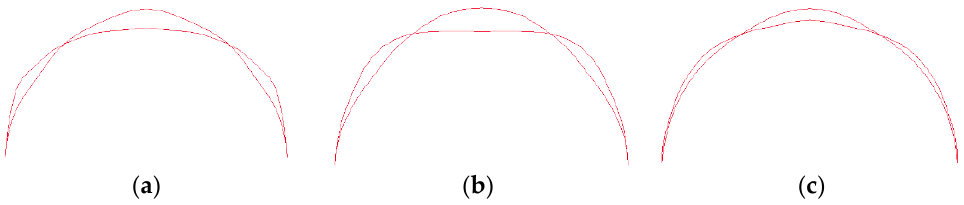
Figure 8. Model of the vertical view, the plan view and the detonation arrangement. ( a ) Vertical view. ( b ) Plan view. Table 1. The total energy with different density of mesh. Table 1. The total energy with different density of mesh. Table 1. The total energy with di ff erent density of mesh.